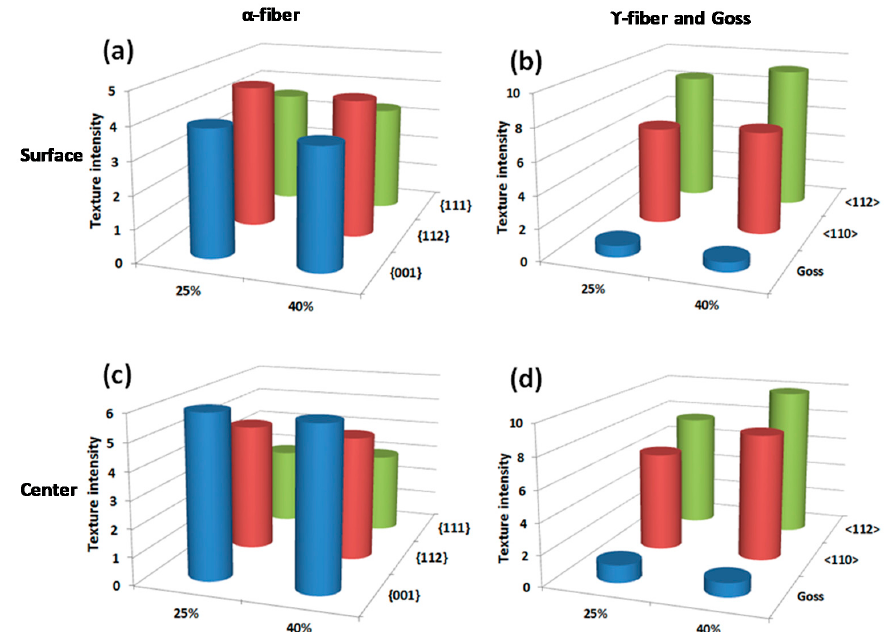
Figure 3. The influence of rolling reduction on the surface and centreline textures of the ferrite rolled strip: ( a ) α -fiber and ( b ) γ -fiber and Goss texture of surface layer; ( c ) α -fiber and ( d ) γ -fiber and Goss texture of center layer with rolling reduction of 25% and 40% at 700 °C with polyphosphate lubricant.